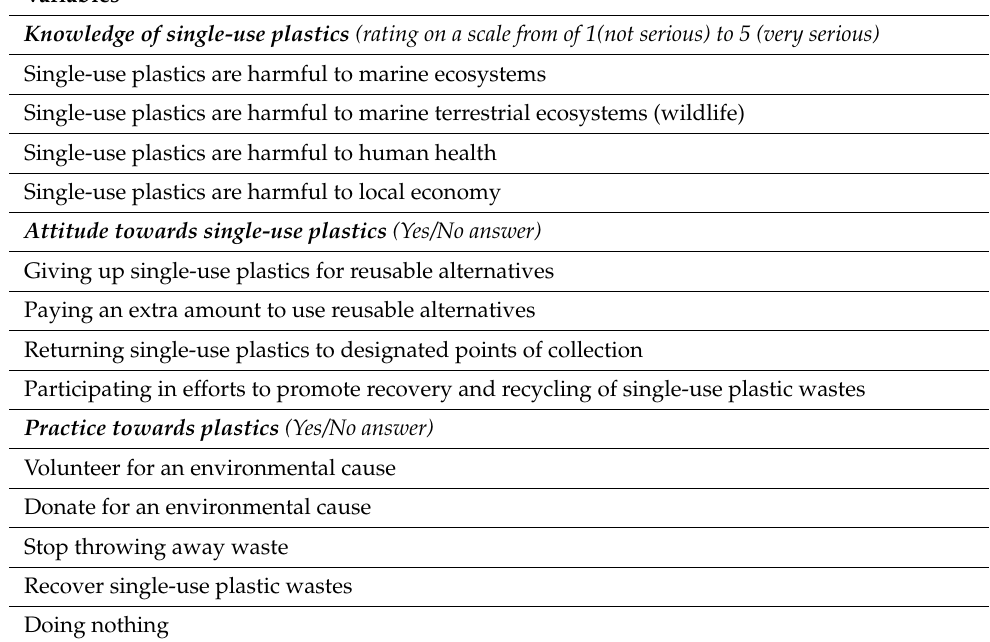
Table 1. Questionnaire